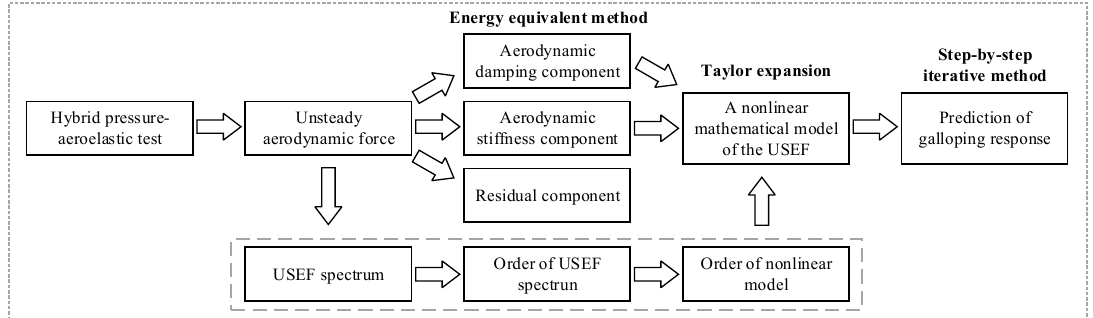
Figure 22. Scheme for modeling the unsteady self-excited force and predicting the galloping response of a bluff body.